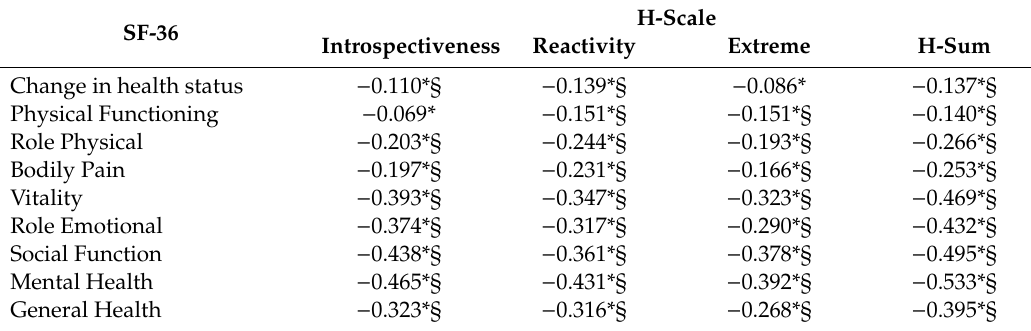
Table 3. Correlations between H-Scale and SF-36.